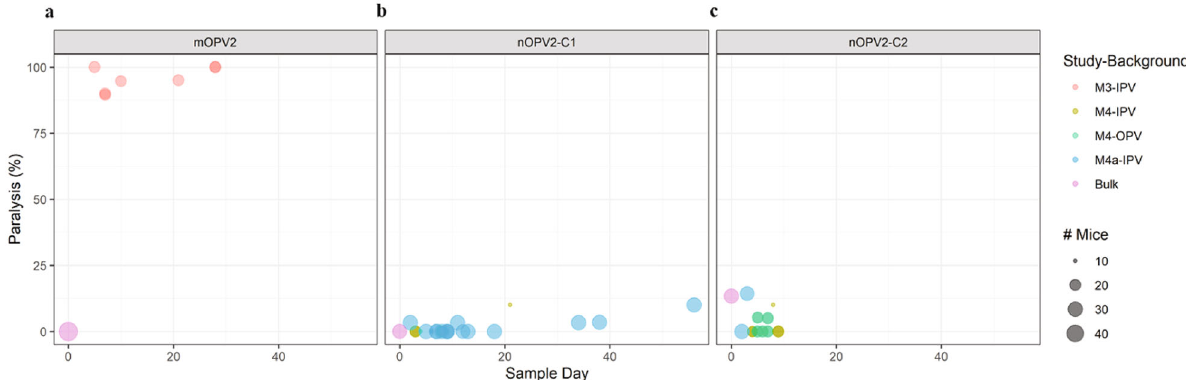
Fig. 9 Measured paralysis rate in modi fi ed mouse neurovirulence test. Vaccine bulk lots and culture-ampli fi ed virus (10 4 CCID 50 /5 ul dose) from each EES were tested in replicates as indicated by plot size. Paralysis rate per administered vaccine bulk lot is shown on day 0. Paralysis rate for shed virus samples is indicated versus day of EES. a mOPV2, b nOPV2-c1 c